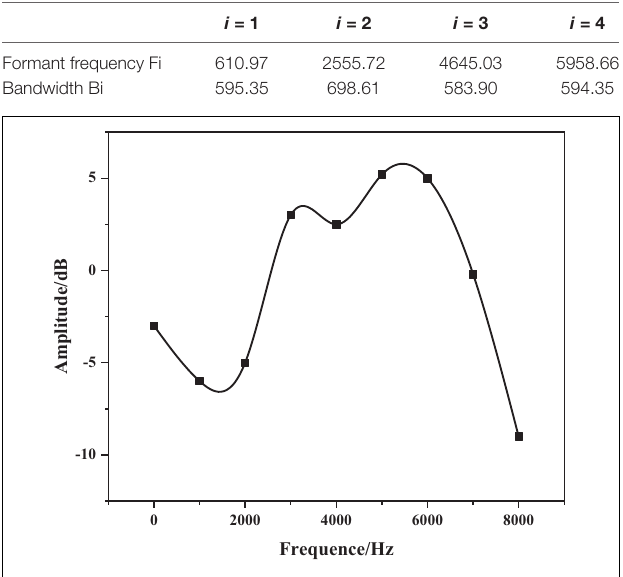
TABLE 2 | Formant frequency and bandwidth values.